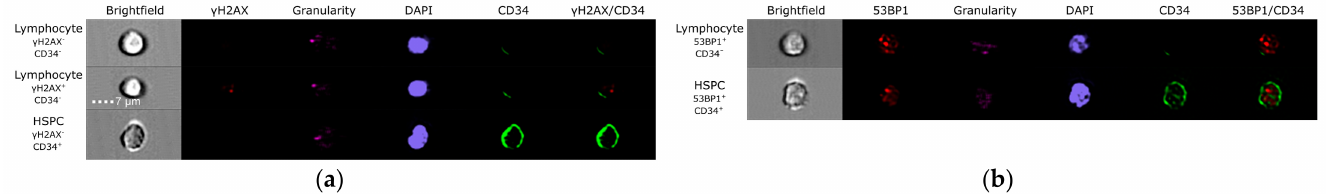
Figure 3. Representative images of double-strand breaks (DSBs) in RUNX1-RUNX1T1 PFG + UCB samples analyzed by ImageStream. ( a ) γ H2AX foci. ( b ) 53BP1 foci. Brightfield as forward scatter, granularity as side scatter, γ H2AX, and 53BP1 proteins as indicators of DSBs, DAPI for DNA, and CD34 antibody against HSPCs are